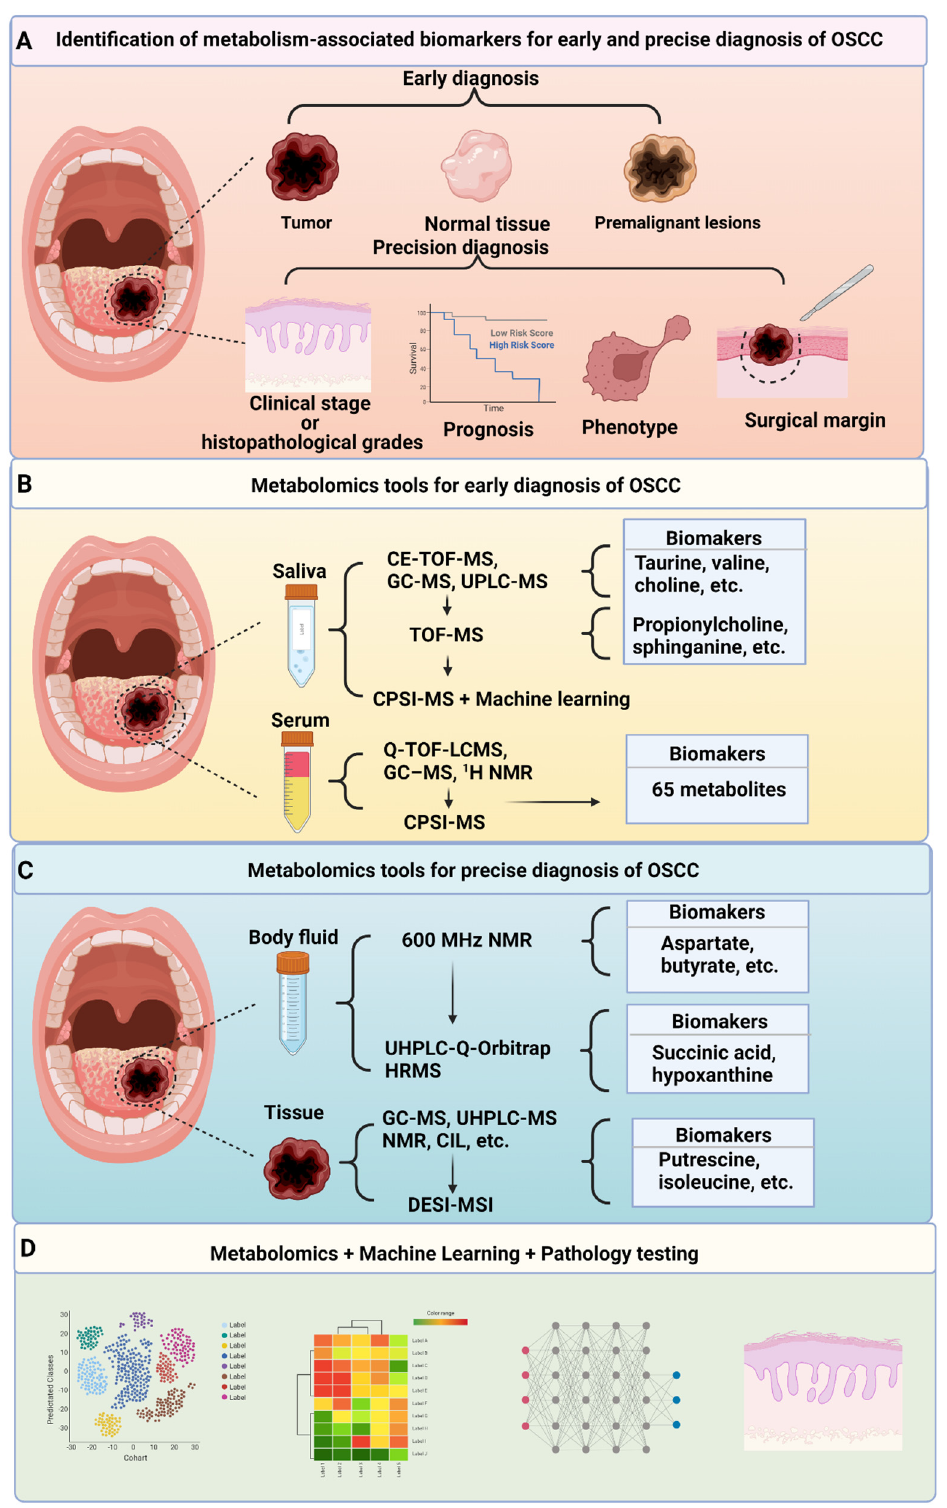
Figure 2. Clinical application of metabolomics to OSCC diagnosis. ( A ). Screening for metabolism-associated biomarkers to assist in early and precise diagnosis of OSCC; ( B,C ). With the advancement of metabolomics tools, some metabolism-associated biomarkers for early and precise diagnosis of OSCC have been screened by testing saliva, serum, body fluid and tissue samples; ( D ). Constructing a diagnostic model combined metabolomics with machine learning and pathology testing is valuable. Figure created with biorender.com.